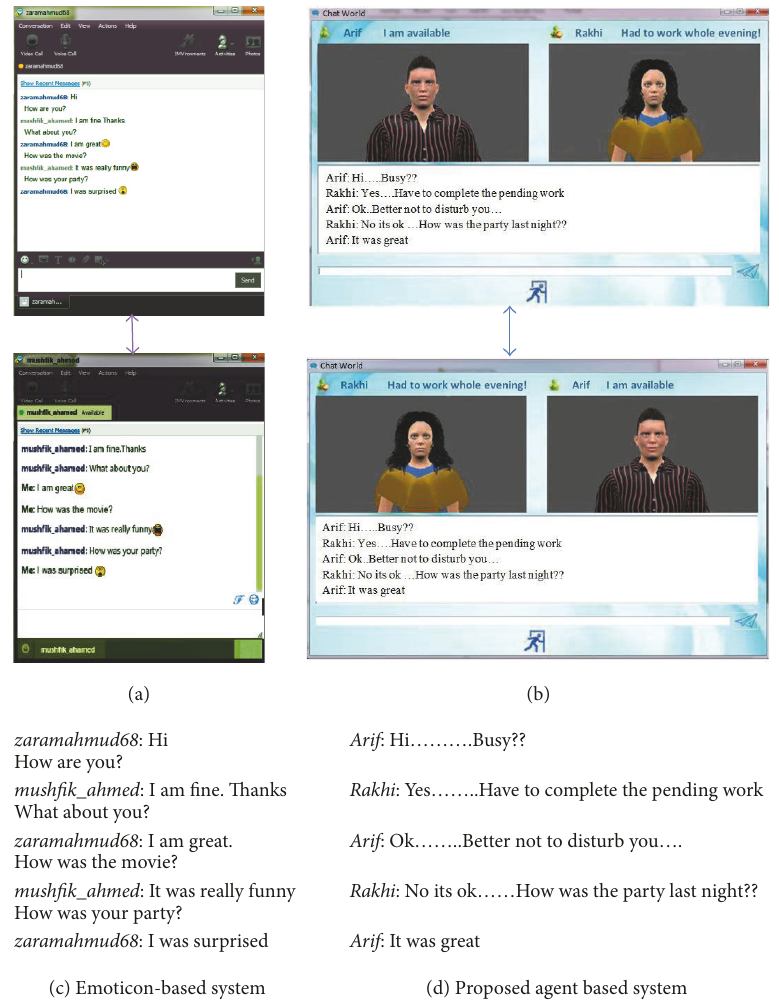
Figure 8: An example scenario of user’s chatting through (a) existing emoticon-based system and (b) our proposed system and a sample of conversation between participants interacting through (c) emoticon-based system and (d) our proposed system.